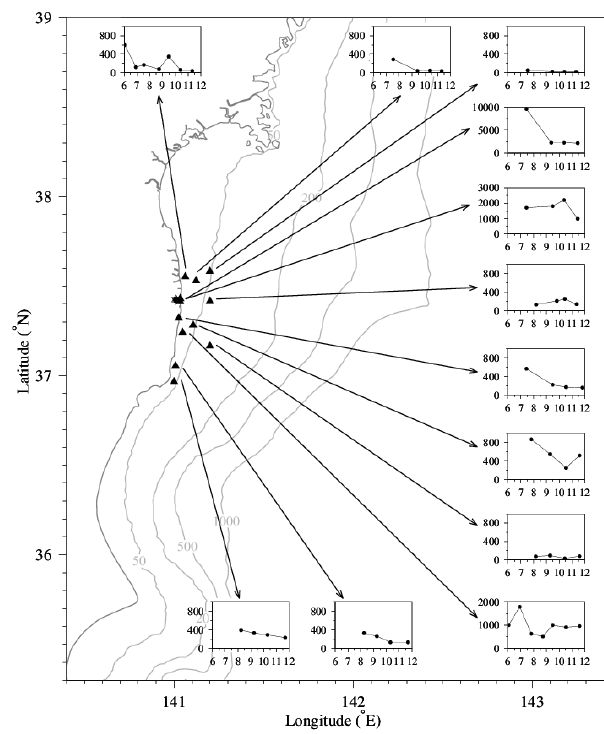
Fig. 16. Time series of the 137 Cs concentration (unit: Bqkg − 1 ) measured in sediments in the nearshore monitoring sites during June–December